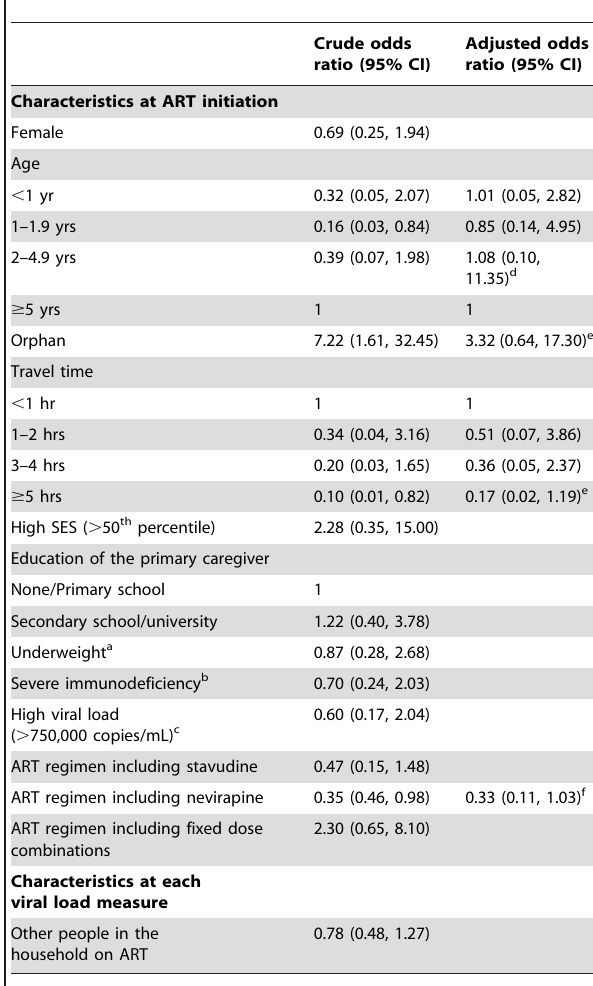
Table 4. Predictors of viral suppression after 6 months of antiretroviral